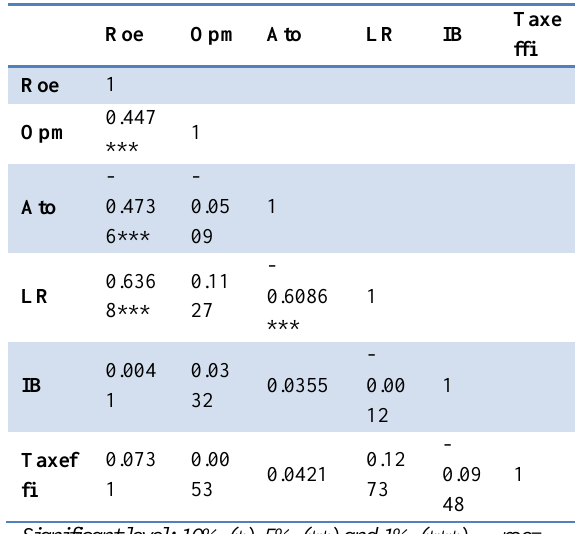
Table 2: Pearson Correlation Matrix During Profit Decline